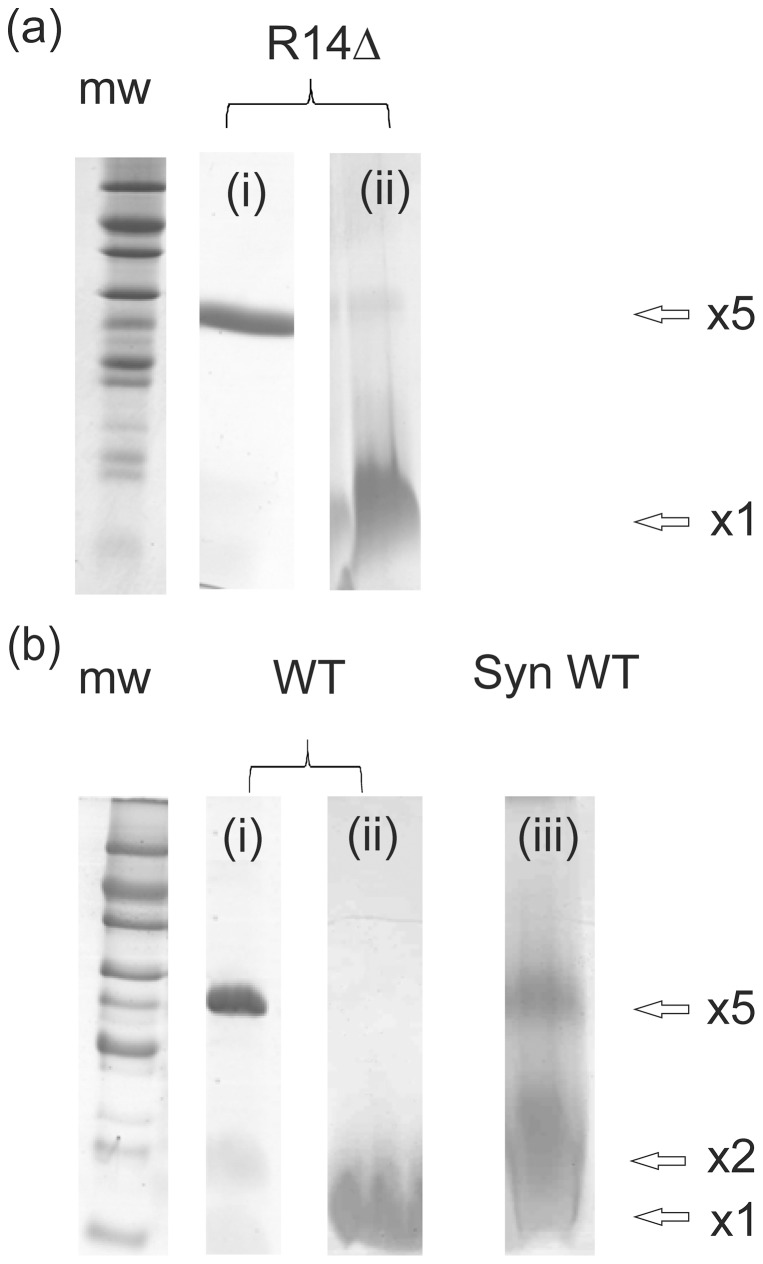
Analysis of the oligomeric distribution of wild-type and mutant PLB by SDS-PAGE:Comparison of recombinant PLBWT and PLBR14Δ in isolation and reconstituted with SERCA (Rec WT and Rec R14 Δ) at an approximate molar ratio of 20:1 PLB/enzyme. SERCA is also shown alone (right hand lane). All samples were prepared following the standard protocol and solutions provided with the Bolt system (Life Technologies), and then stained with standard Coomassie Brilliant Blue R250. The SeeBlue Plus2 Pre-Stained Standards were also supplied with the Bolt system; the apparent molecular weights shown on the gel are those expected when run on a NuPAGE Novex 4–12% Bis-Tris Gel with MES. Protein migration patterns are dependent on the buffer system used; in a more typical Tris/Glycine system, the migration pattern of the same markers would differ, with apparent molecular weights as follows: 4, 6, 16, 22, 36, 50, 64, 98, 148 and 250.